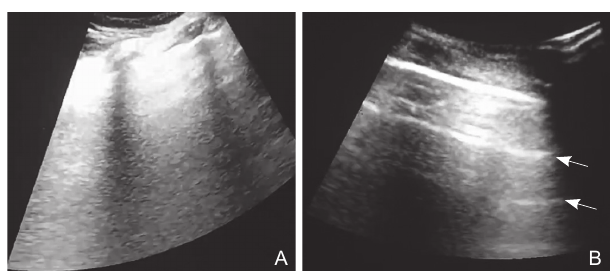
A Figure 3 Pulmonary ultrasound pre- and post-treatment of severe COVID-19 case. (A) The BLUE spot showed a "waterfall sign" (white screen) pre-treatment. (B) The white screen disappeared and A-line appeared (arrows) post-treatment. Table 3 Comparison of transthoracic ultrasound and HRCT scores pre- and post-treatment Item Transthoracic ultrasound HRCT